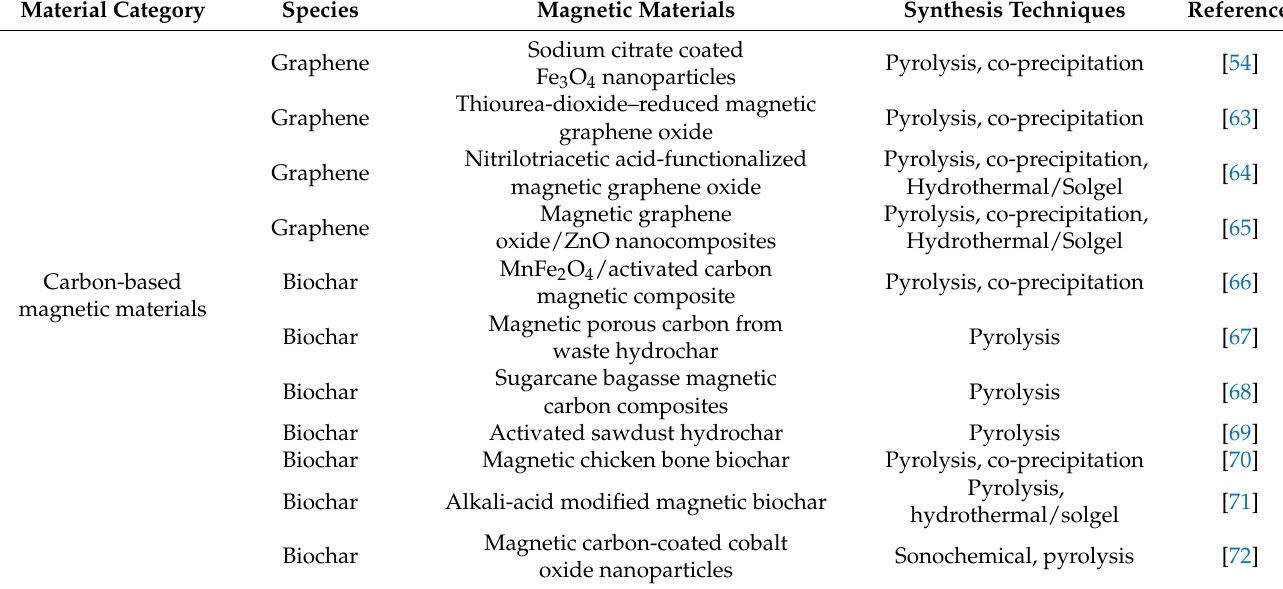
Table 1. The main preparation methods for magnetic materials.